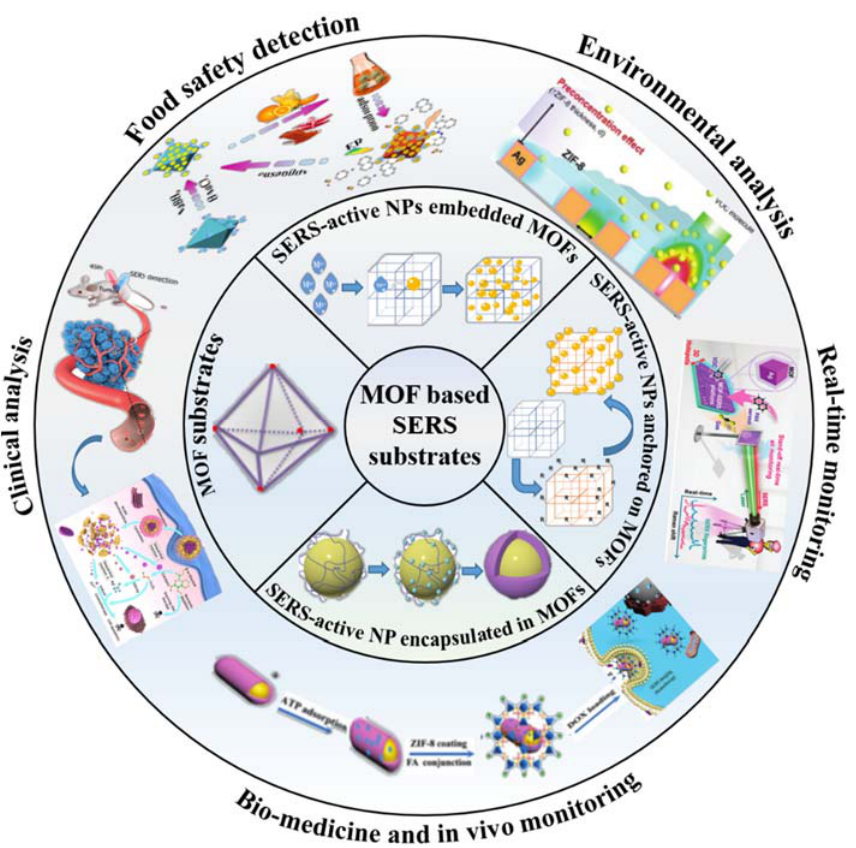
Figure 1. Schematic illustration of the synthesis and applications of MOFs based SERS substrates.